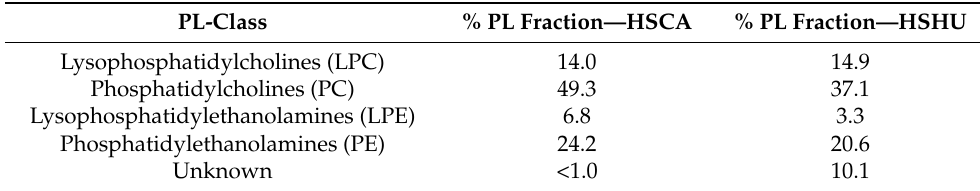
Figure 3. 31 P spectra of MeOH fraction of hemp cake ( a ) and hemp seed hulls ( b ) collected from SPE. LPC—lysophosphatidylcholine, PC—phosphatidylcholine, LPE—lysophosphatidylethanolamine, PE—lysophosphatidylethanolamines, UN—unknown. Table 5. Percentage proportion of phospholipids in MeOH fraction collected from SPE as determined by 31 P NMR.